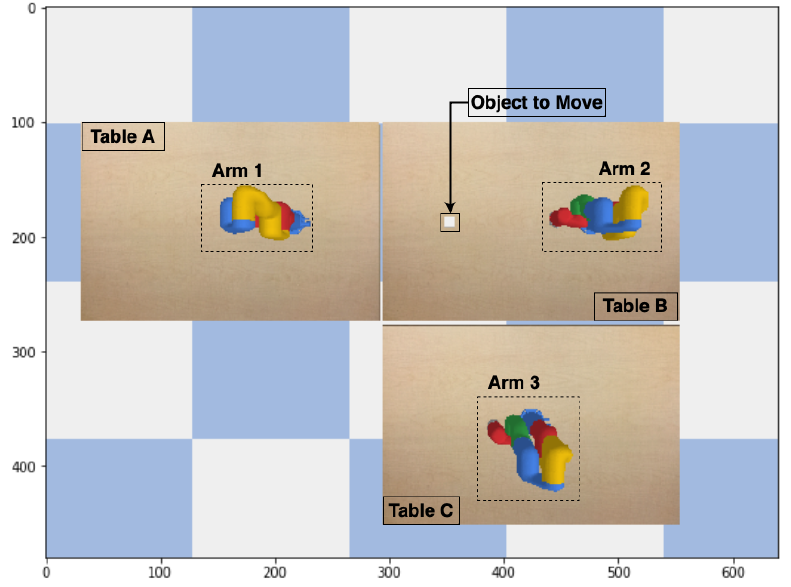
Figure 3. Environment setup for the case